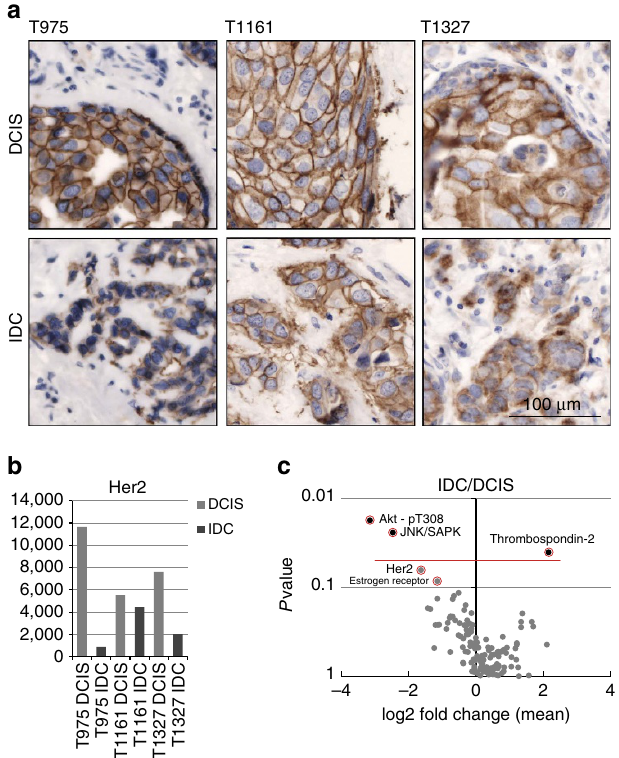
Figure 6 | DigiWest from LCM-derived primary tumour cells. Paired IDC and DCIS LCM samples were analysed using DigiWest.( a ) Her2-stained sections, paired IDC and DCIS from three patients. ( b ) Her2 signals for the LCM samples on DigiWest. ( c ) Volcano plot representing the mean IDC/DCIS ratio for all measured analytes versus significance. P values were derived from t -tests with Welch approximation. The data contained in this volcano plot are based on quantified signals obtained from an equivalent to about 1,000 western blot